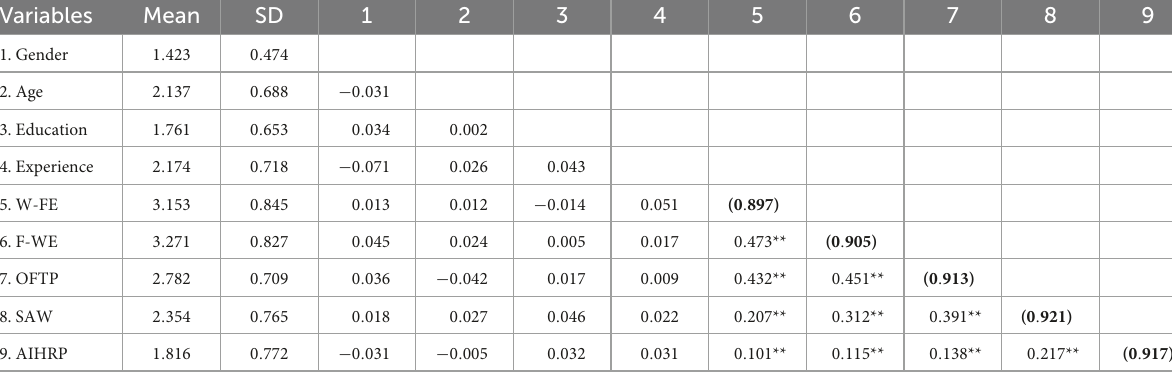
TABLE 2 Mean, SD, correlations, and